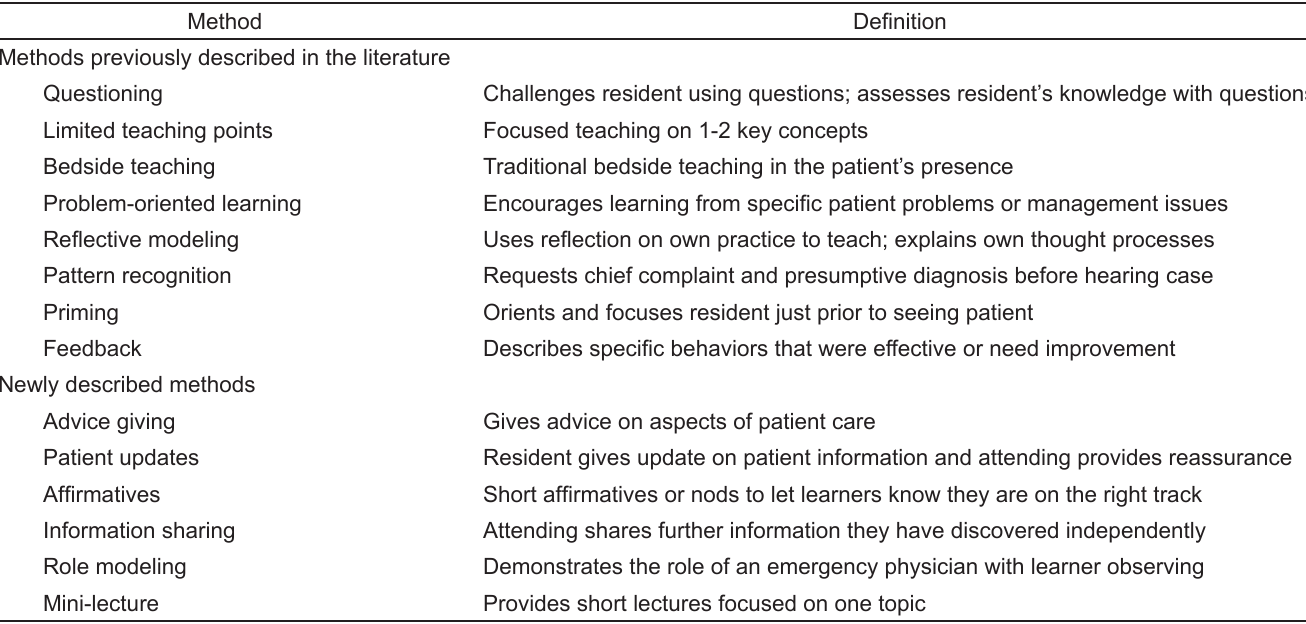
Table 1. Teaching methods, previously reported and newly described, with definitions (adapted from Grall et al. emergency medicine teaching